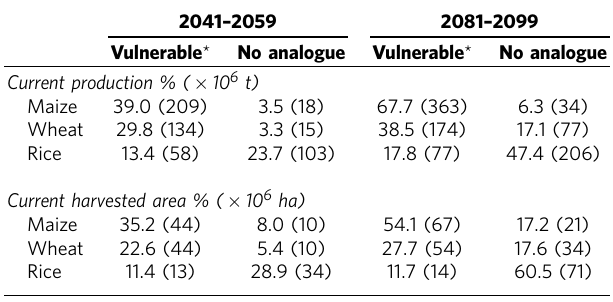
Table 1 | Portion of current global production and harvested area in vulnerable or no-analogue zones for at least four out of five GCM